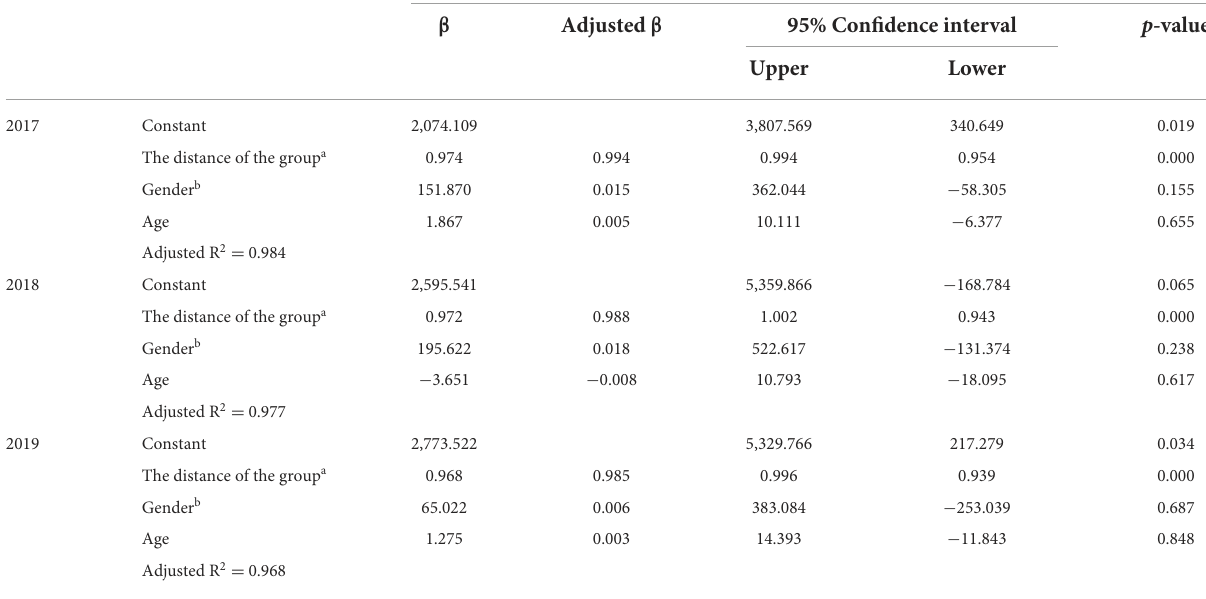
TABLE 8 Predictive accuracy of diabetes (multiple regression analysis).